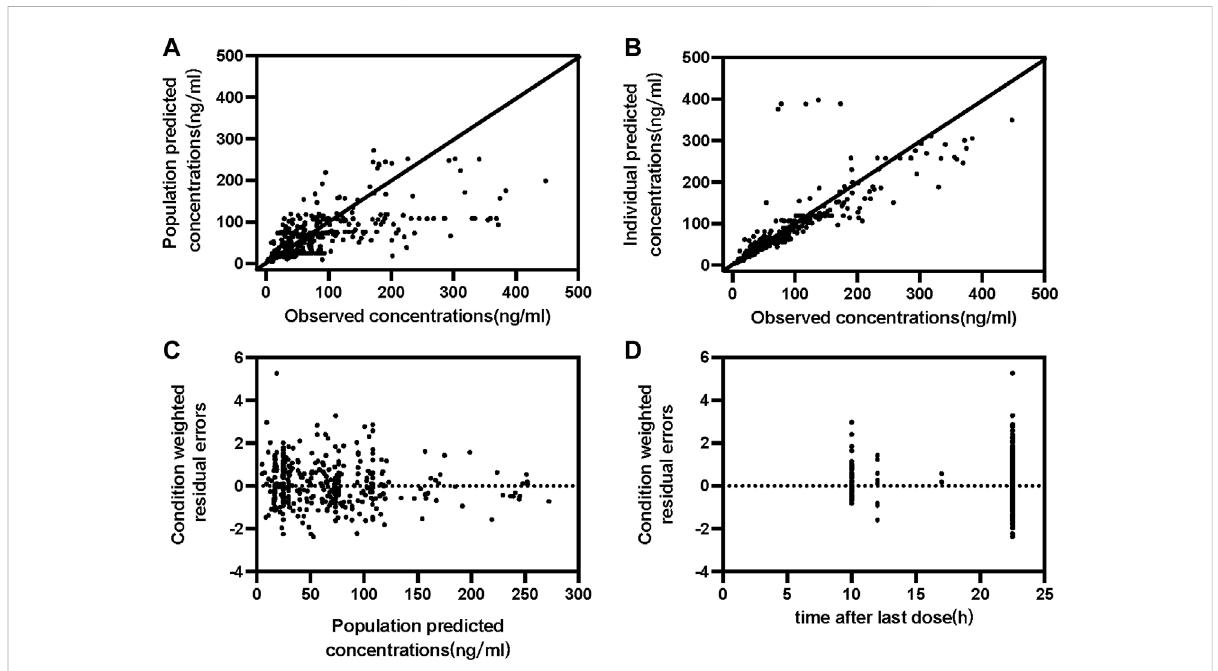
FIGURE 1 Goodness-of- fi t plots of the fi nal population PK model for paroxetine concentration set. (A) Observed concentration vs. Population predicted concentrations (B) Observed concentration vs. Individual predicted concentrations; (C) Conditional weighted residual errors vs. Population predicted concentrations (D) Conditional weighted residual errors vs. time after last dose.